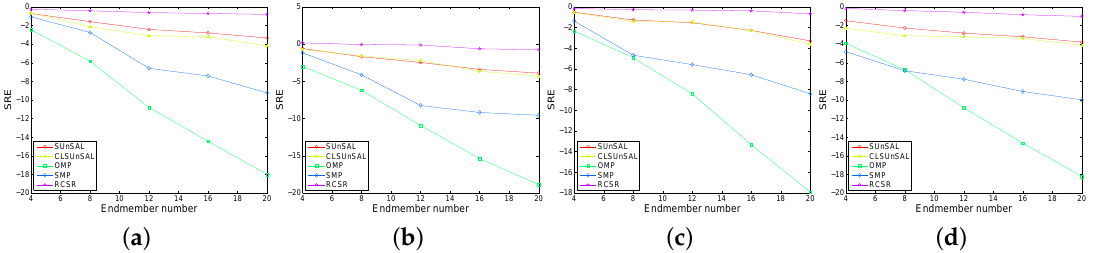
Figure 5. Performance of SRE as a function of the number of endmembers under correlated noise when the SNR is 10 with the ( a ) LMM; ( b ) FM; ( c ) GBM and ( d ) MGBM.